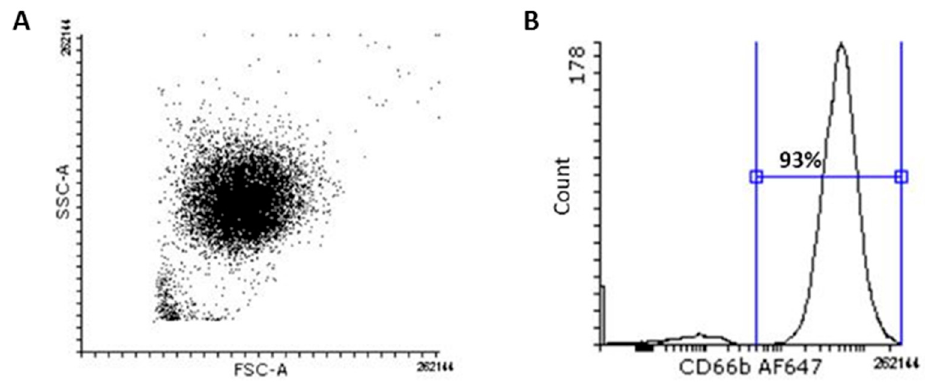
Figure A3. Flow cytometry analysis of CD66b staining on isolated human neutrophils. ( A ) Forward-side-scatter profile of isolated polymorphonuclear neutrophils (PMNs); ( B ) Isolated PMNs were stained with CD66b, a marker for PMNs, to determine purity of neutrophil isolation. A total of 93% of the isolated cell population was positive for CD66b.